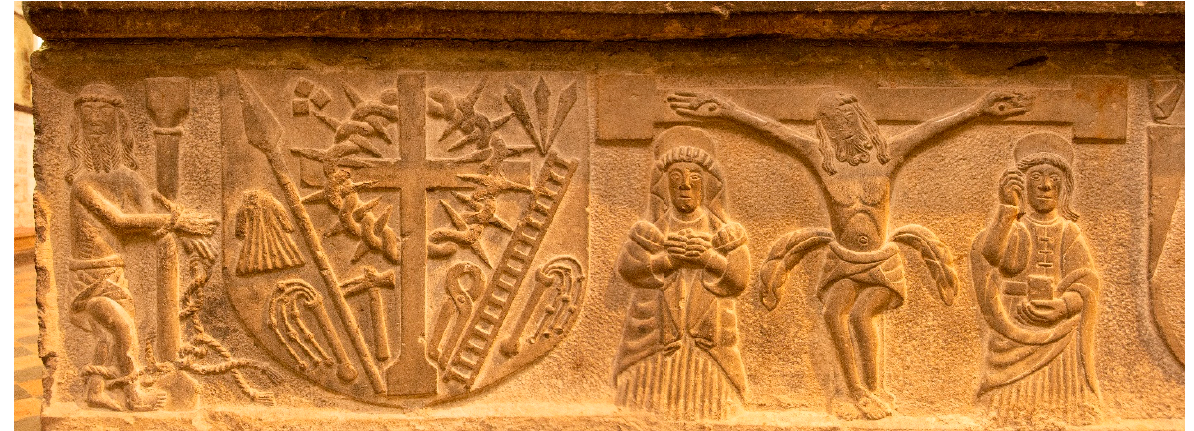
Figure 28. Tomb of Piers and Margaret Butler, St Canice’s, Co. Kilkenny, c.1539. Photograph by the